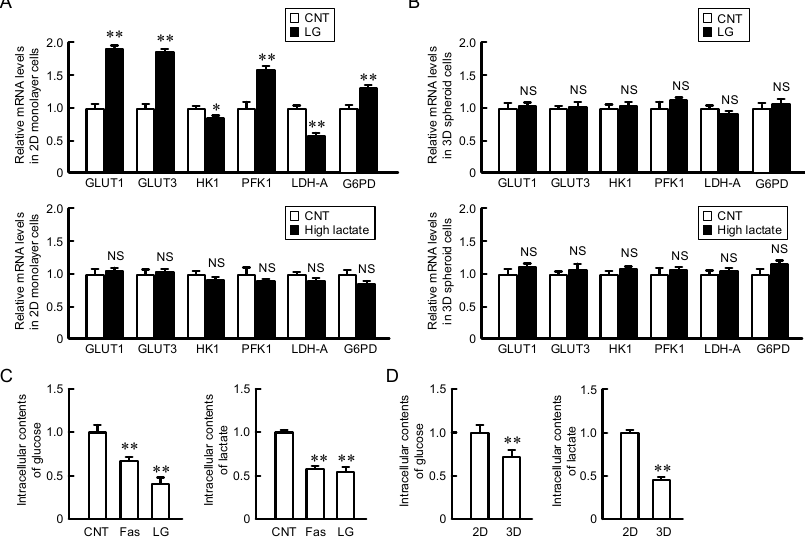
Figure 4. Effects of low glucose and high lactate on the expression of glucose transporters and metabolic enzymes in 2D monolayer and 3D spheroid cells. ( A ) A549 monolayer cells were incubated with the media containing 25 mM glucose (CNT), 5 mM glucose (LG), or 20 mM lactate (High lactate) for 6 h. ( B ) A549 spheroid cells were incubated with the media containing 25 mM glucose (CNT), 5 mM glucose (LG), or 20 mM lactate (High lactate) for 6 h. Real-time PCR was performed using primer pairs as indicated. The mRNA levels are represented relative to the values in CNT. ( C ) A549 cells were cultured on 6 cm flat dishes were in the absence (CNT) and presence of 10 µ M fasentin (Fas) or 5 mM glucose (LG) for 6 h. ( D ) A549 cells were cultured on 6 cm flat dishes (2D) and 96-well round-bottomed plates (3D). Intracellular contents of glucose and lactate were measured using each assay kit and represented relative to the values in CNT or 2D. n = 3–4. ** p < 0.01 and * p < 0.05 compared with CNT or 2D. NS, p >